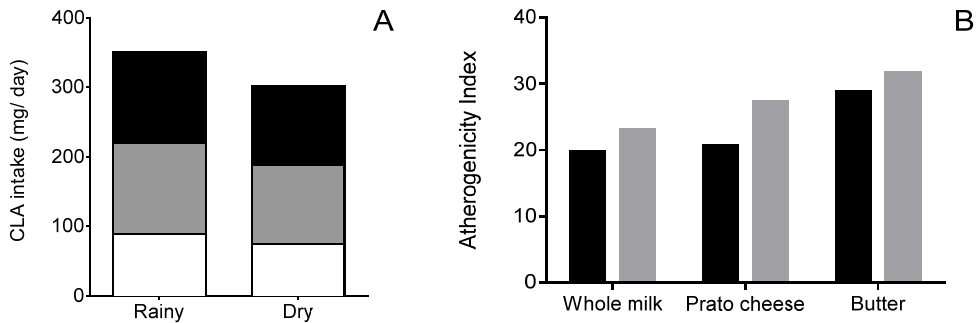
Figure 3. Estimated per capita intake of CLA ( A ) and atherogenicity index ( B ) associated with consumption of milk fat from dairy products in southeastern Brazil. Spring and summer were the rainy seasons and autumn and winter were the dry seasons. ( A ): Dairy products: (cid:4) Butter; prato cheese; whole milk. ( B ): (cid:4) Rainy season; Dry season.